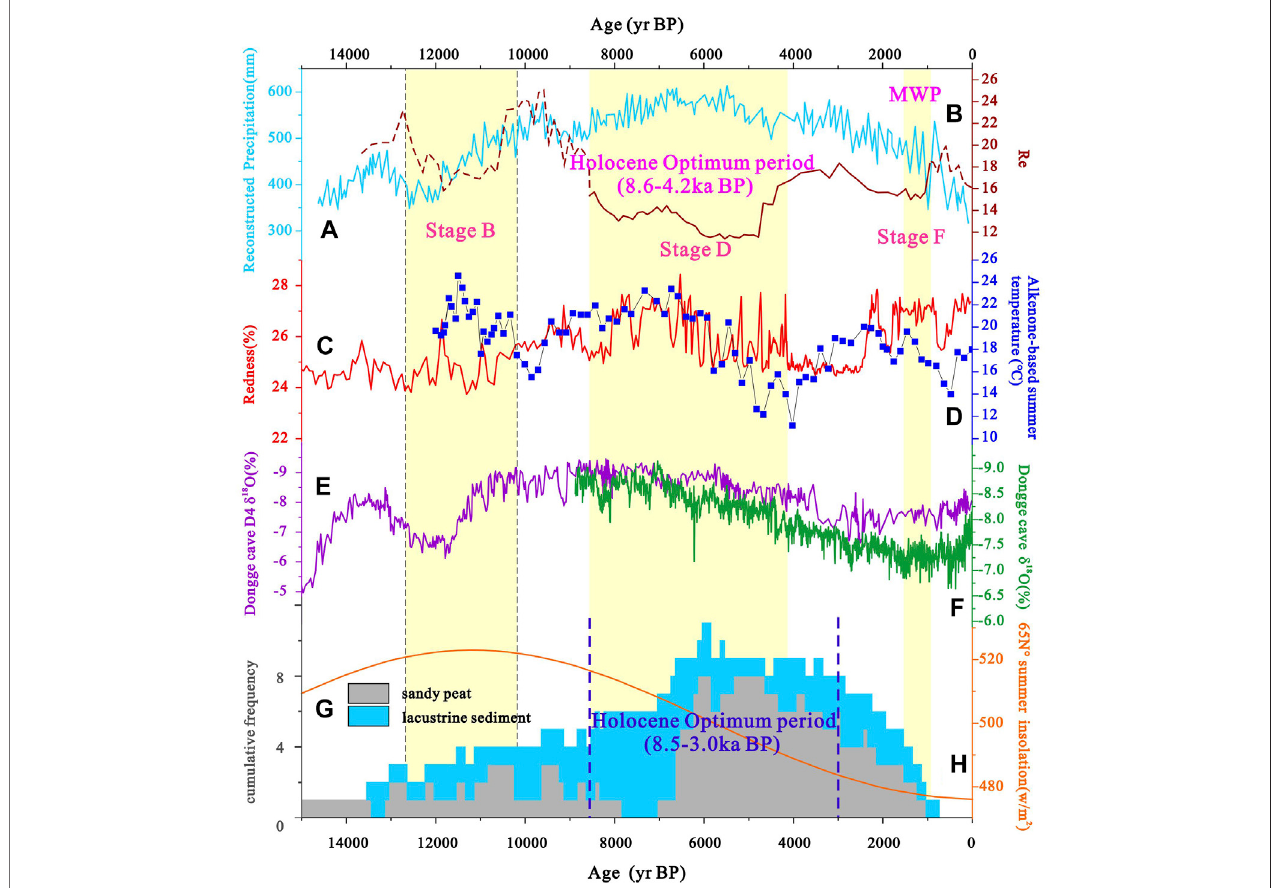
FIGURE 5 | Variations in the Ratio of Elements (Re) representing the degree of drought since the Last Deglaciation period and selected environmental proxies. (A) Annual precipitation records from Gonghai Lake, northern China (Chen et al., 2015). (B) Re from this paper. (C) Redness curve of Qinghai Lake which re fl ects precipitation (Ji et al., 2005). (D) Alkenone-based summer temperature record from Lake Qinghai (Hou et al., 2016). (E) Dongge cave stalagmite D4 oxygen isotope record (Dykoski et al., 2005). (F) Dongge cave stalagmite oxygen isotope record (Wang et al., 2005). (G) Synthesis of variations in hydrological conditions inferred from peat-containing pro fi les (Liu et al., 2018a). (H) Northern Hemisphere summer insolation at 30 ° N (Berger and Loutre, 1991).